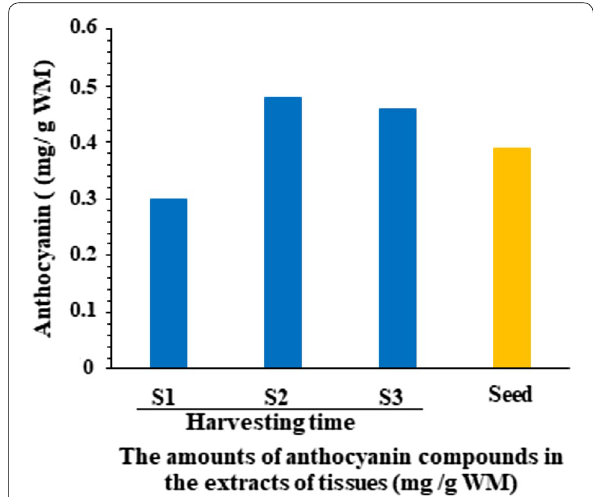
Fig. 4 The amounts of anthocyanin compounds in the extracts of tissues (mmol/g WM). *mmol anthocyanin per gram of wet plant material